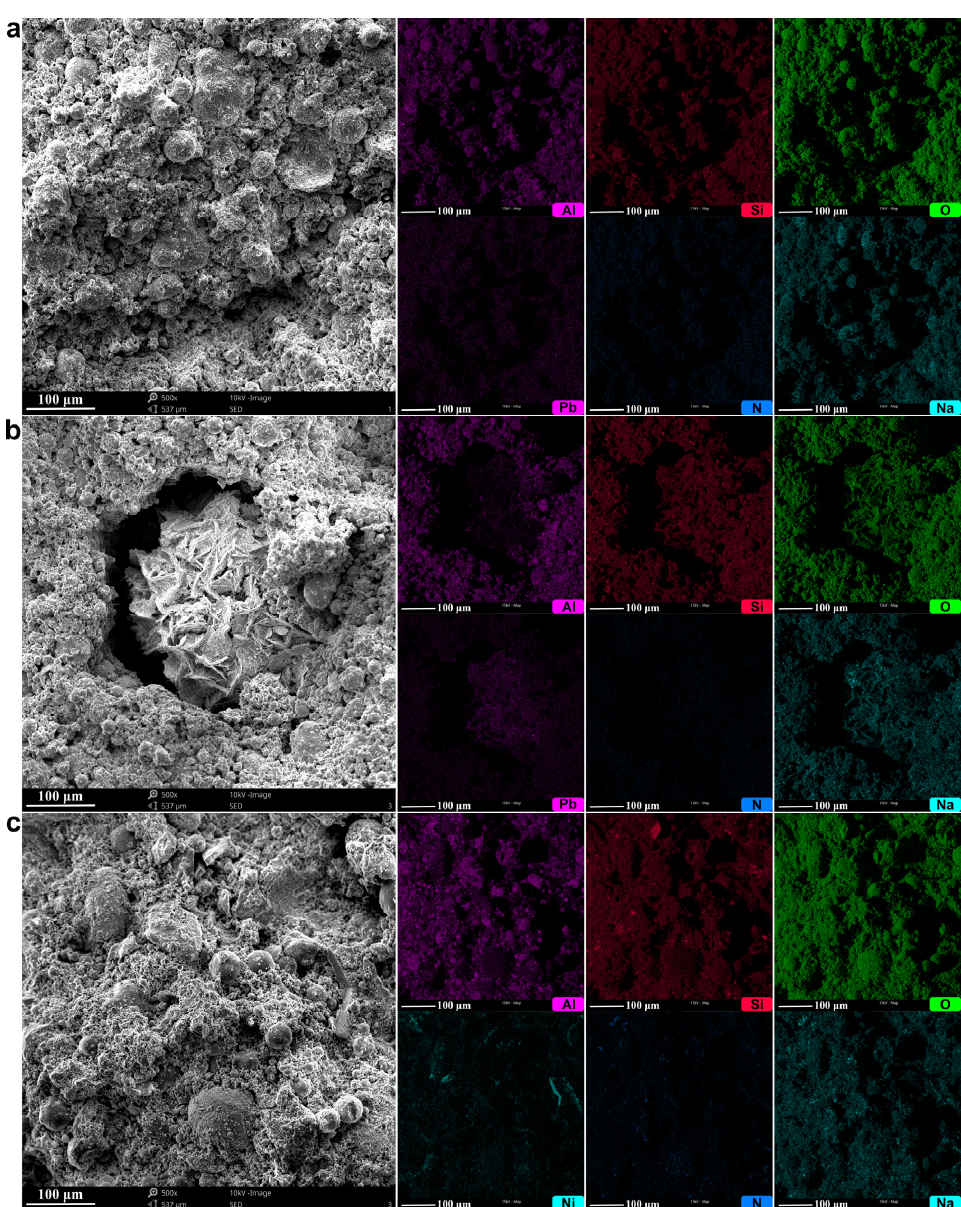
Figure 11. SEM images and EDS maps of the geopolymers with heavy metals: ( a ) the general image of the sample with Pb, ( b ) the inclusion in the sample with Pb, and ( c ) the general image of the sample with Ni. Immobilization properties: The values of heavy metals leaching from the geopoly- meric samples are presented in Figure 12. In the case of the samples with 2 and 4 wt.% of Ni 2+ , the leaching was very low, namely < 0.05 mg/L for the reference sample (without bo- ron). The leaching values were much higher for the reference samples with − 0.6 mg/L (Pb 2+ 2 wt.%) and 2.6 mg/L (Pb 2+ 4 wt.%) of lead. The higher leachability of Pb than of Ni can be attributed to the occurrence of macroscopic crystalline inclusions of PbO· x H 2 O with a sig- nificant solubility in water. Another reason for the higher immobilization efficiency of Ni than Pb may be related to their exchange energies, which are higher for Pb 2+ than Ni 2+ , and